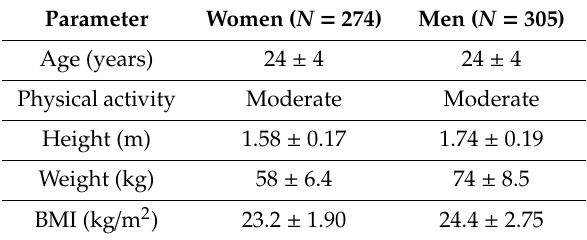
Table 1. Characterization of the studied